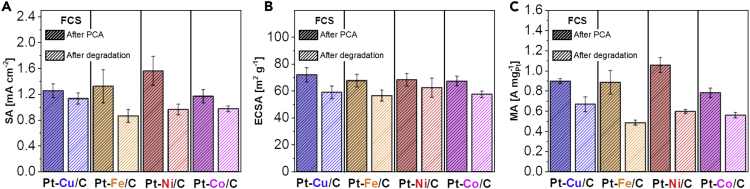
SA, ECSA and MA comparison of Pt-M/C FCS electrocatalysts after PCA and after ADTComparison of (A) specific activity (SA at 0.9 VRHE), (B) ECSACO and (C) mass activity (MA at 0.9 VRHE) of Pt-M/C electrocatalysts evaluated both after PCA (200 cycles in 0.1 M HClO4, 0.05–1.2 VRHE, 300 mV s−1, Ar saturated, 600 rpm) and degradation (ADT; 5000 cycles in 0.1 M HClO4, 0.4–1.2 VRHE, 1 V s−1, Ar saturated, 600 rpm). See also Supplemental informationFigures S18–S20 for ORR polarization curves, CO electrooxidation experiments and calculated Tafel plots that compare the activity after PCA and after ADT. The colors (Pt-Cu = blue, Pt-Fe = orange, Pt-Ni = red and Pt-Co = magenta) correspond to the ones used for the graphs and borders in all of the figures.